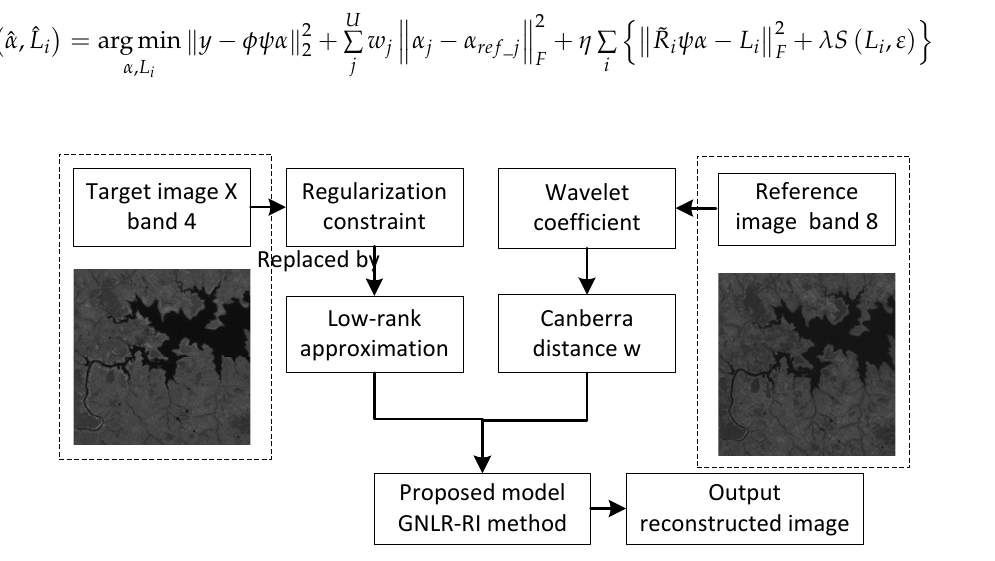
Figure 3. Framework of the proposed GNLR-RI